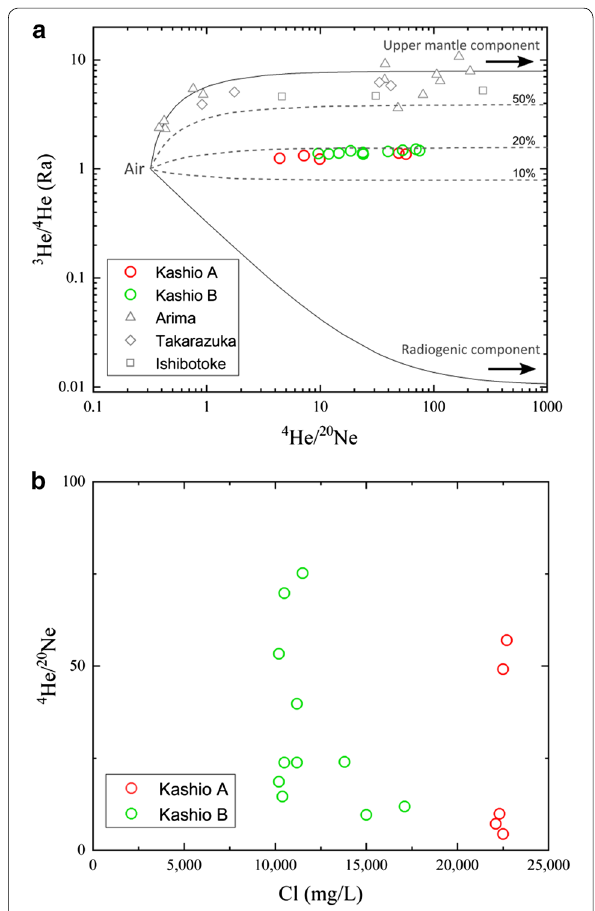
Fig. 4 Relationship between 3 He/ 4 He, 4 He/ 20 Ne, and Cl in water samples from the Kashio A and B wells. a Relationship between helium isotope ratio ( 3 He/ 4 He) and 4 He/ 20 Ne. The two solid curves indicate the mixing lines between the upper mantle and radiogenic components and air, respectively. Three gray dashed lines indicate the mixing between air and the supposed end-member containing the upper mantle component partially (10%, 20%, and 50%). For comparison, data from the previous studies of Arima, Takarazuka, and Ishibotoke are also plotted (Nagao et al. 1981; Sano and Wakita 1985; Matsumoto et al. 2003; Morikawa et al. 2005; Kusuda et al.